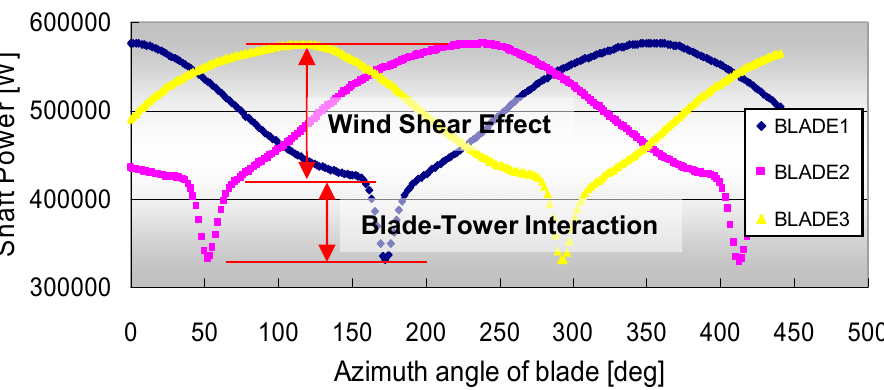
Figure 7. Simultaneous pressure distribution around tower. Two different aerodynamic fluctuations with 3P frequency are distinctively observed.